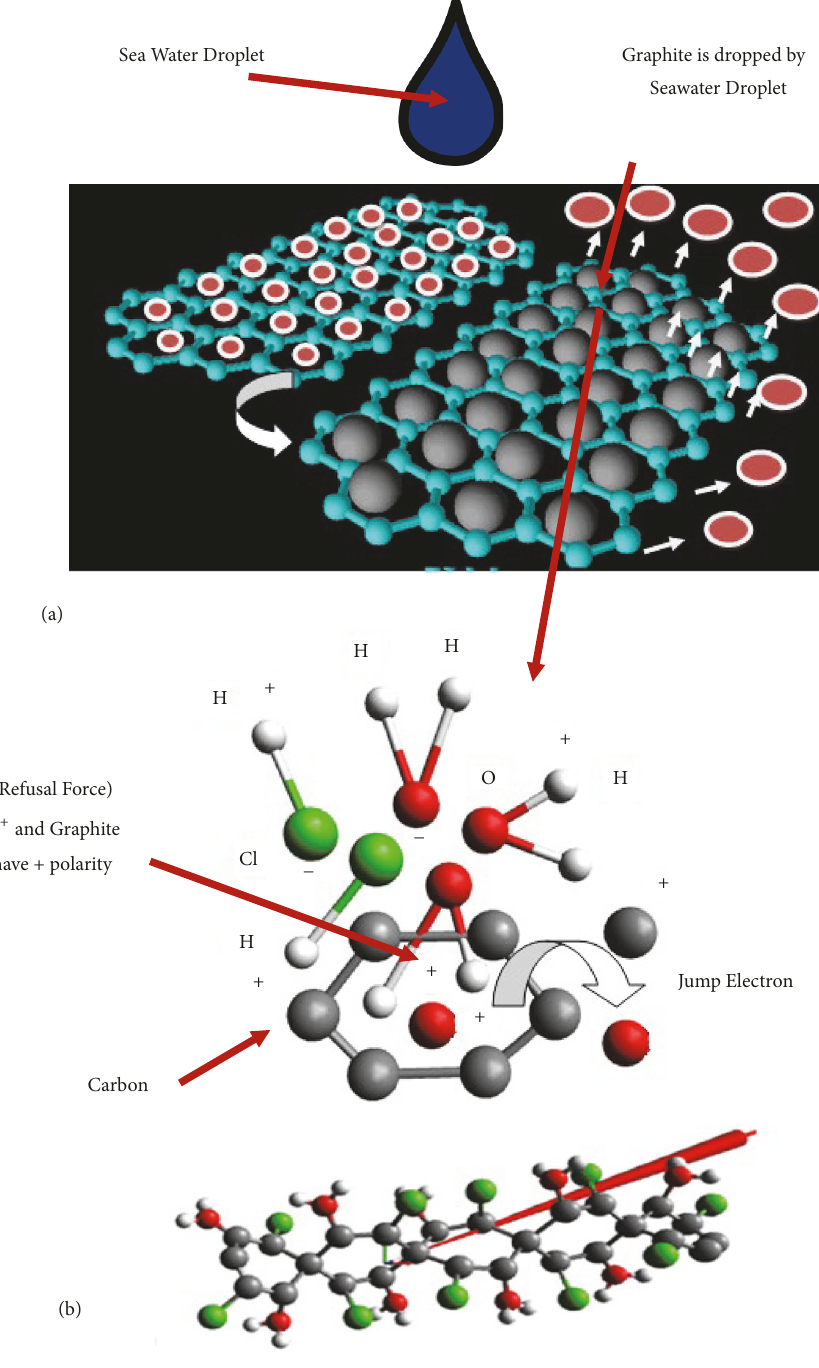
Figure 5: (a) The graphite is dropped by sea water. (b) The graphite and sea water element bonding.